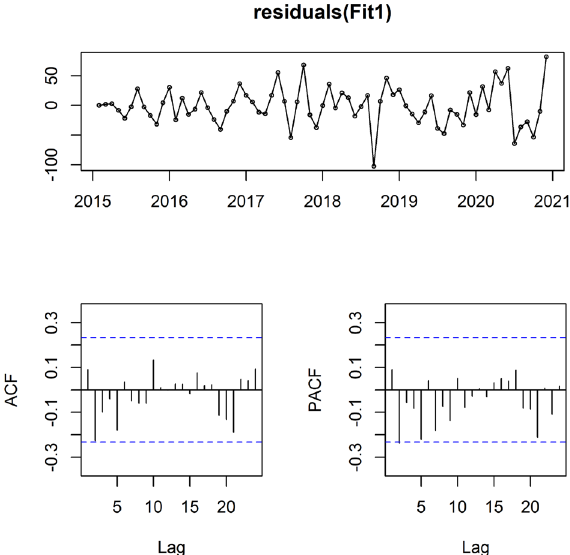
Figure 2. The general trend of the residuals series with ACF and PACF plots.